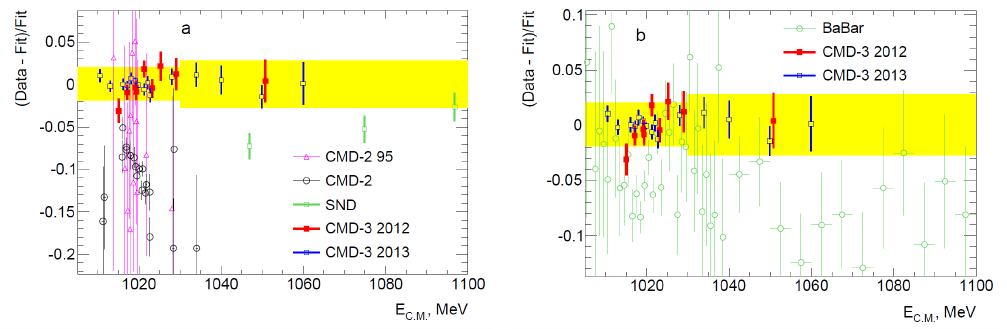
Figure 4. Comparison of the CMD-3 measurement of e + e − → K + K − to previous measurements at CMD-2 [19, 20] and SND [21].